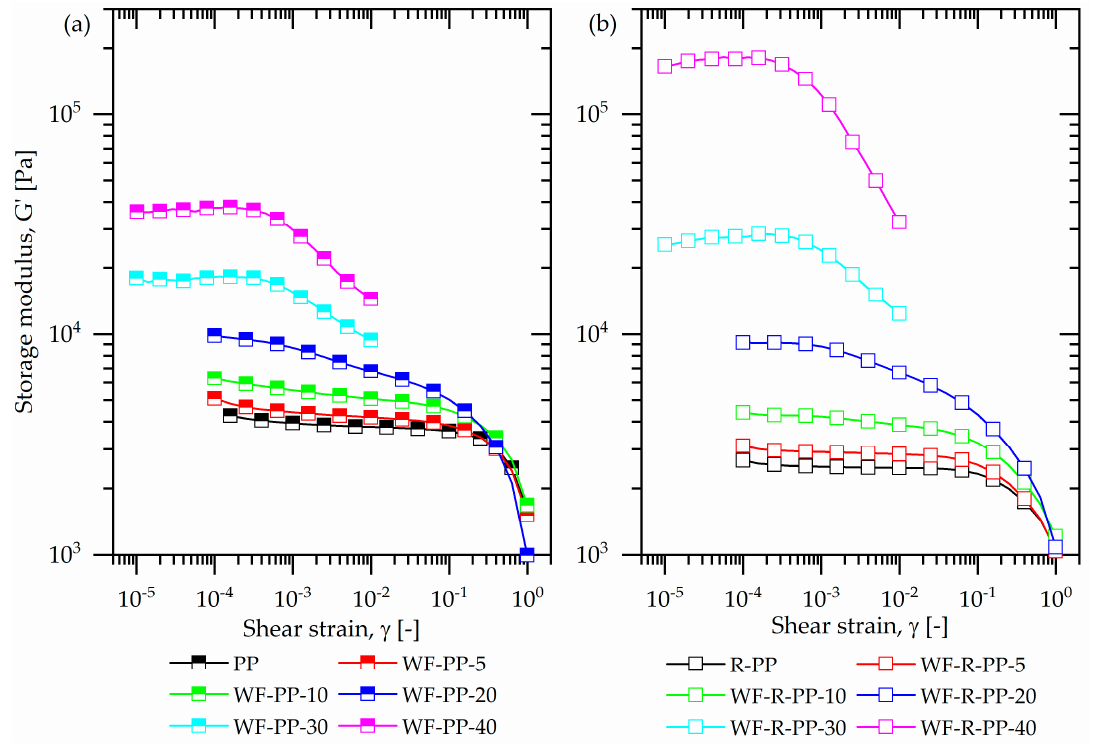
Figure 8. Storage modulus, G’ as a function of shear strain, γ at 6.28 rad/s and 190 °C for ( a ) unrecycled material and ( b ) recycled material.